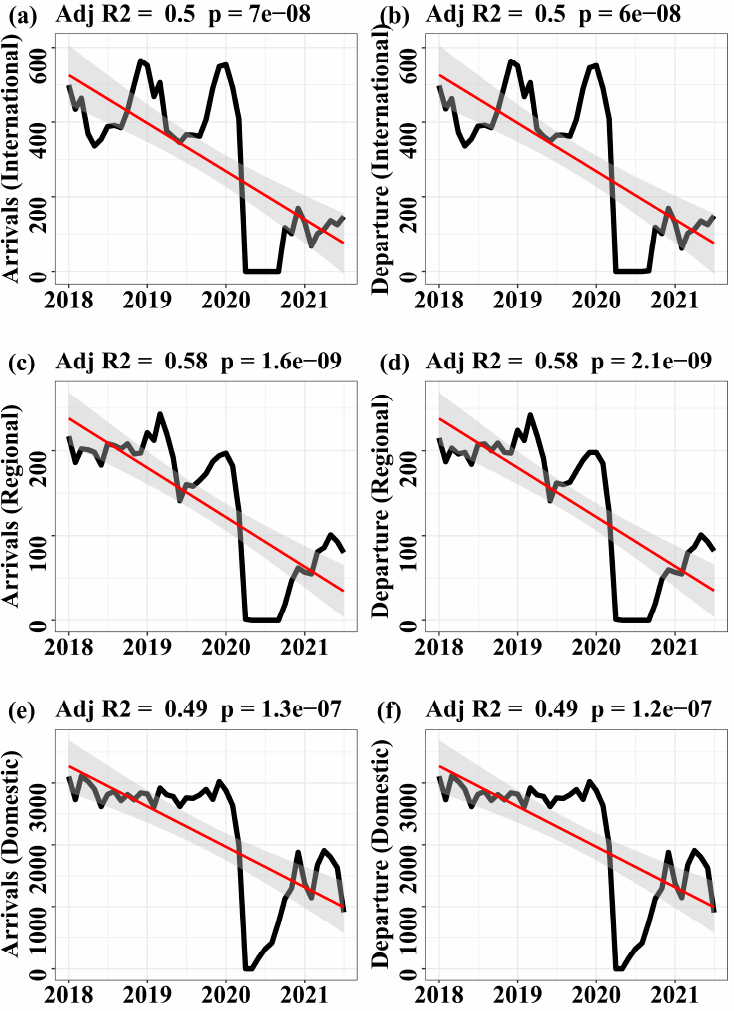
Figure 2. The linear trend analysis of international, regional, and domestic aircraft movements from 2018 to 2021 at Cape Town International Airport (FACT). ( a , b ) show trends in international arrivals and departures, respectively, ( c , d ) show trends in regional arrivals and departures, respectively, while ( e , f ) show trends in domestic arrivals and departures,